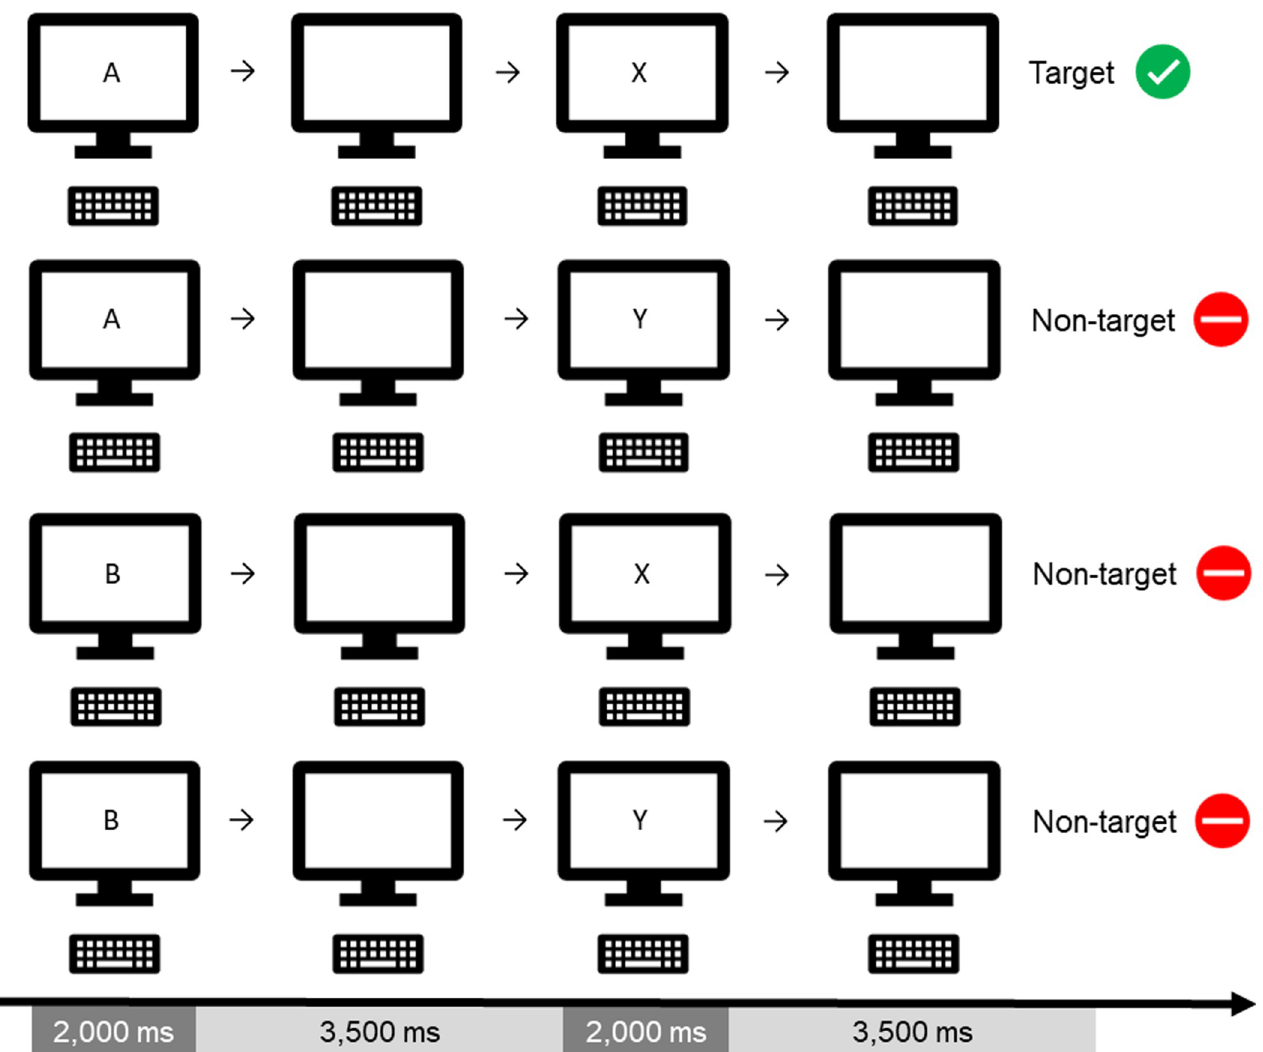
Fig 2. AX-CPT. In our version of the AX-CPT, the target pair will be A-X. A-Y, B-X, as well as B-Y pairs will be non-targets. This task will be used as the digital single-task and will be the primary task in the dual- and multitasking